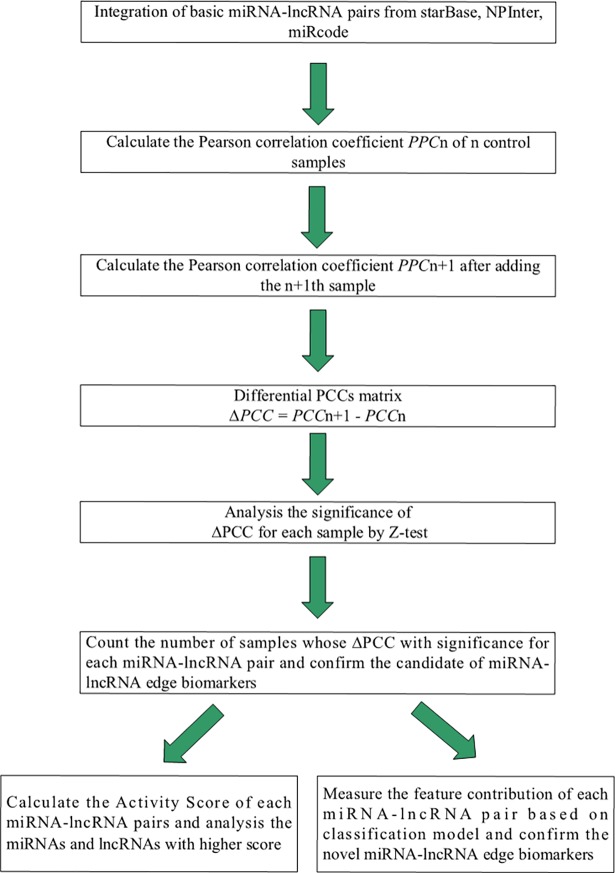
Entire flowchart.